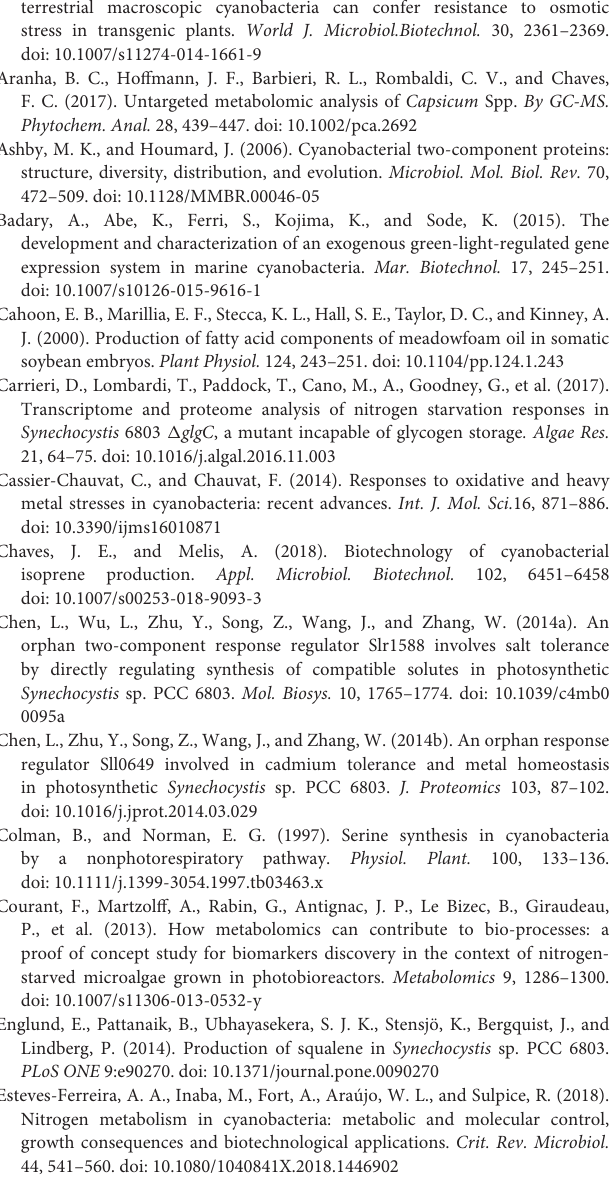
Figure S3 | Pathway view of metabolite changes in 1 sll1291 , differential regulated metabolites were represented by color, red for down-regulated and green for up-regulated metabolites. Figure S4 | Pathway view of metabolite changes in 1 slr1909 , differential regulated metabolites were represented by color, red for down-regulated and green for up-regulated metabolites. Table S1 | Primers used for quantitative real-time RT-PCR in this study. Table S2 | GC-MS metabolomics dataset of 44 mutants under autotrophic